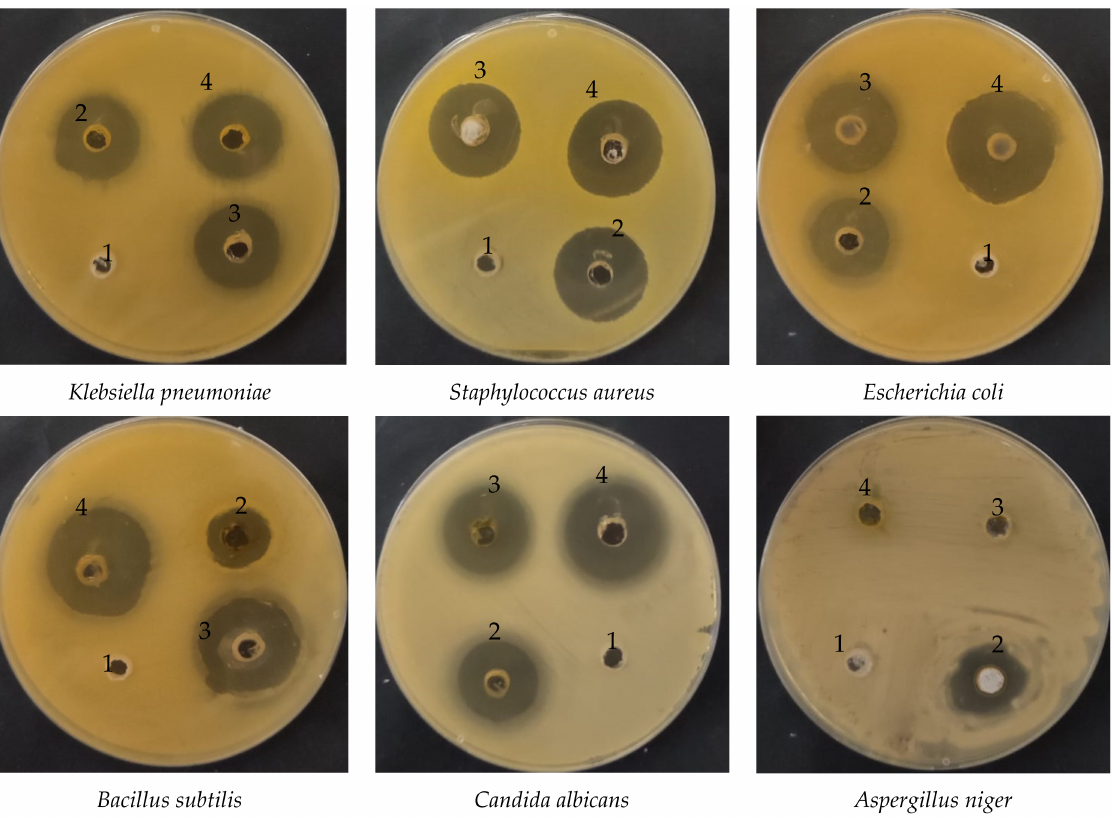
Figure 5. Well-diffusion assays to assess the [1] activity of chitosan, [2] positive controls (antibi- otic/antifungal), [3] Artemisia judaica extract, and [4] chitosan nanoparticles (CNPs) loaded extract against pathogenic bacterial and fungal